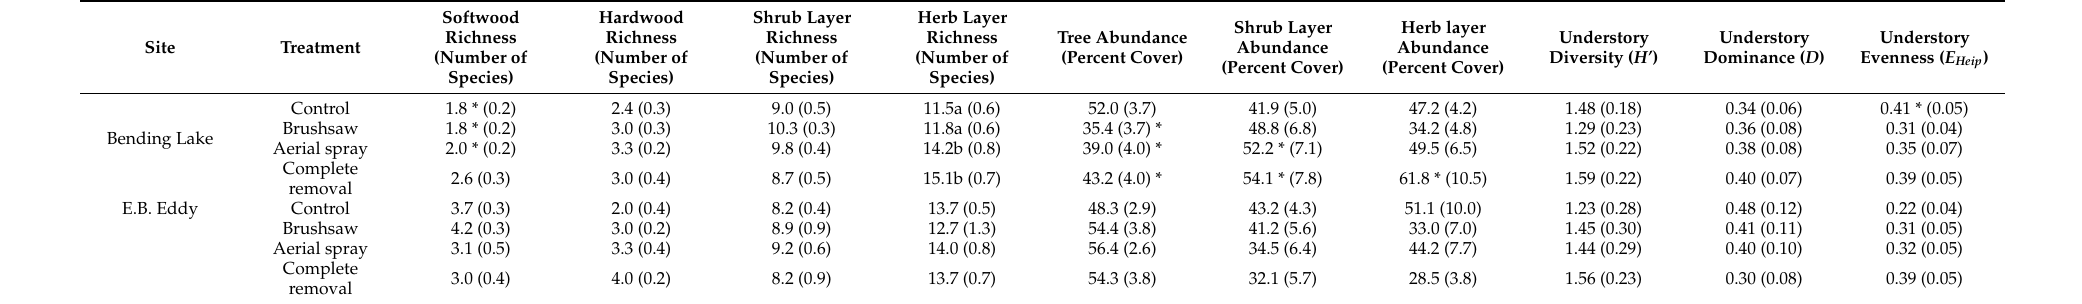
Table 2. Estimated marginal means ( ± SE) for biodiversity indicators ( n = 85) grouped by site x treatment variables after vegetation management treatments applied on two sites (Bending Lake and E.B. Eddy) in Ontario, Canada. Different lowercase letters indicate statistically significant differences from Tukey’s honest significant difference (HSD) test (pairwise comparisons between each treatment and control) in each site. Asterisk (*) indicates statistically significant results from pairwise comparisons between